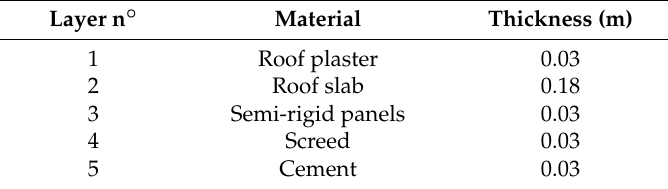
Table 3. Baseline building: Roof composition, from the external to the internal layer.